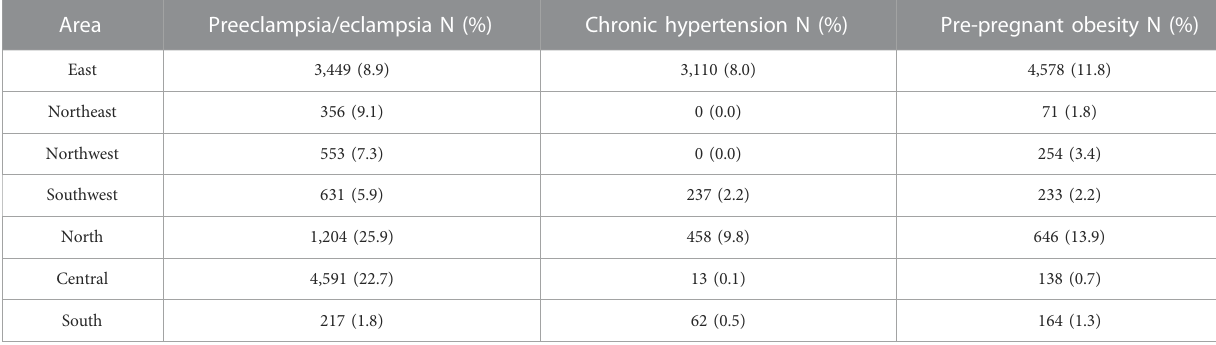
TABLE 1 Weighted ratio of stillbirths with risk factors via Chinese geographical